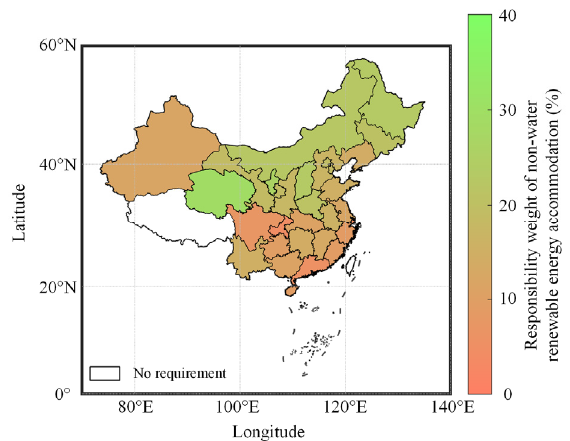
Figure 7. Completed RWNWREA of China in 2021.